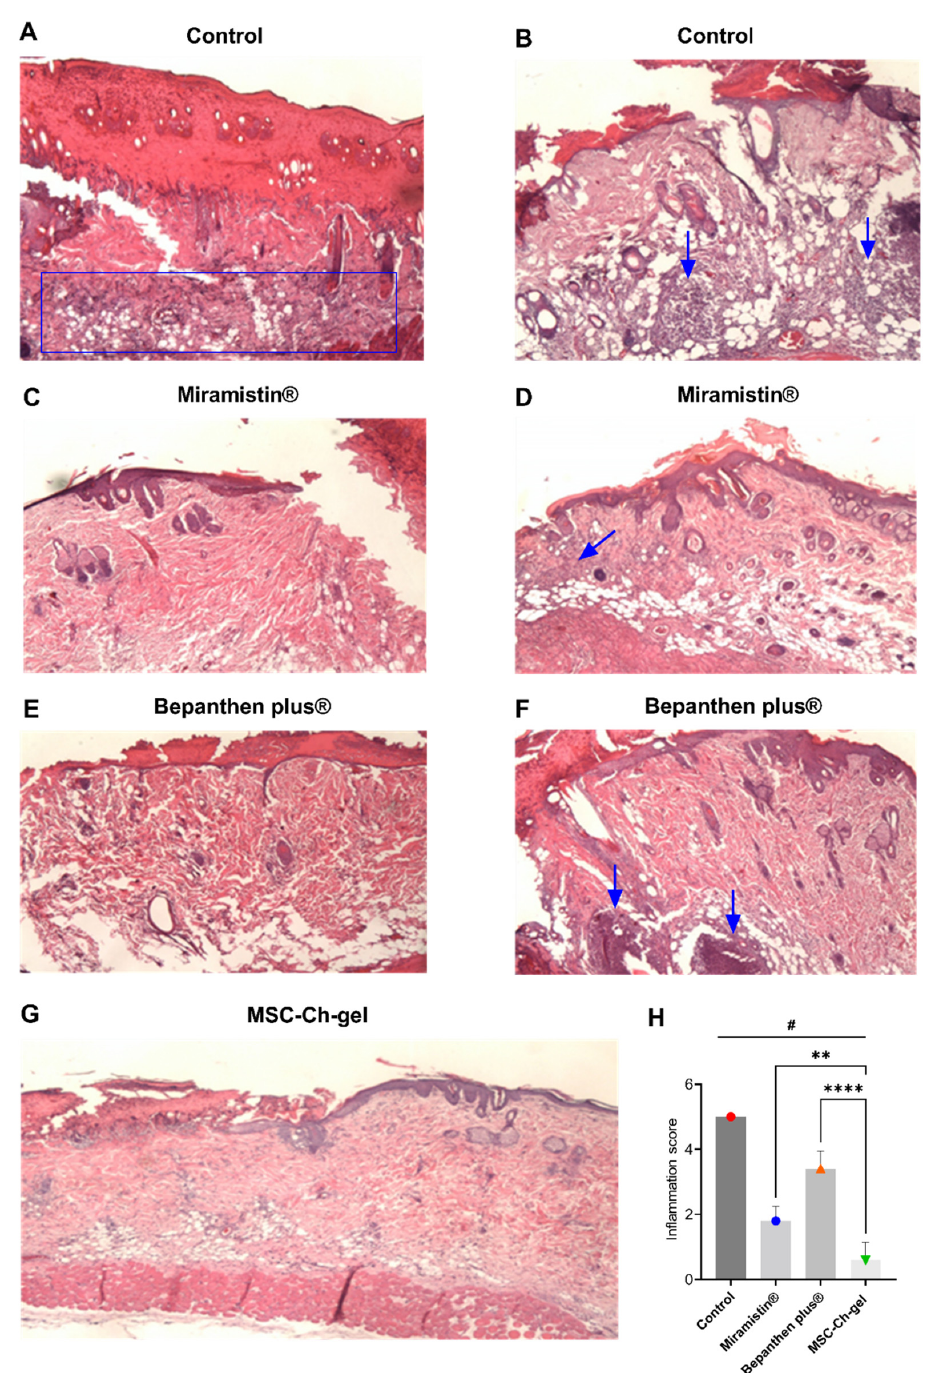
Figure 6. Histology of skin lesions on day 4 stained with haematoxylin and eosin, and inflammatory infiltrate score on days 4. ( A , B ) Control. ( C , D ) Miramistin. ( E , F ) Bepanthen Plus. ( G ) MSC-Ch-gel (magnification, ×40). The blue rectangle and arrows indicate the area of the inflammatory infiltrate. ( H ) Inflammation score. Plotted data are means ± standard deviation ( n = 5), # adjusted p < 0.001 for Control vs. Miramistin, Bepanthen Plus, and MSC-Ch-gel groups, ** adjusted p 0.0031 for Miramistin vs. MSC-Ch-gel, **** adjusted p < 0.001 for Bepanthen Plus vs. MSC-Ch-gel. All statistical analyses were performed using the one-way ANOVA. To compare groups vs Control (Dunnett’s post hoc test); to compare groups with each other (Tukey’s post hoc test). MMSC, multipotent mesenchymal stromal cell; MSC-Ch-gel, multipotent mesenchymal stromal cell secretome-based chitosan gel.